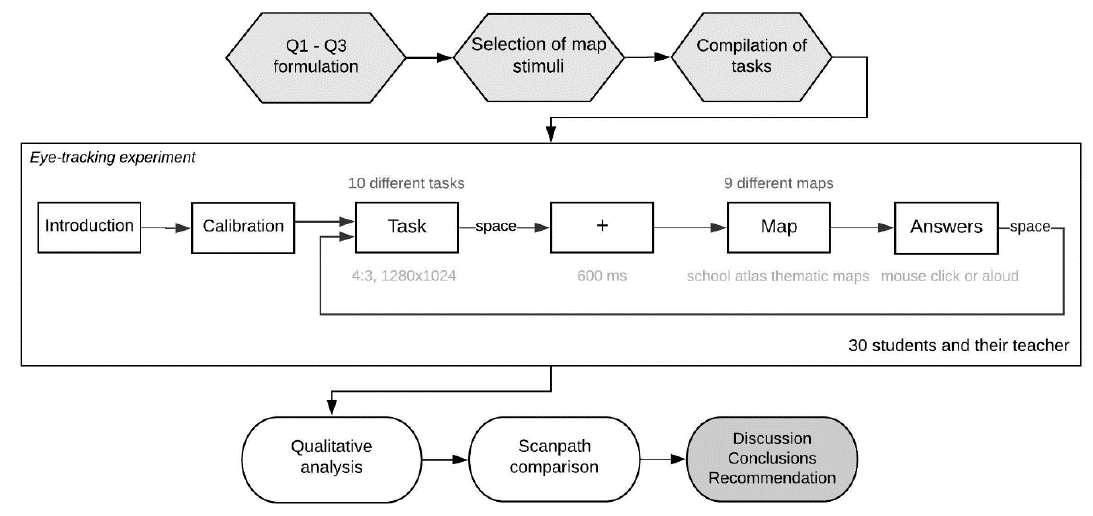
Figure 1 . Scheme of the study. Figure 1. Scheme of the